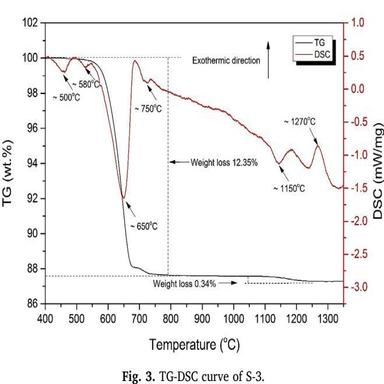
XRD patterns of different samples. (a) S-3 sintered at different temperatures for 2 h and (b) samples with different magnesite addition sintered at 1250 °C for 2 h.